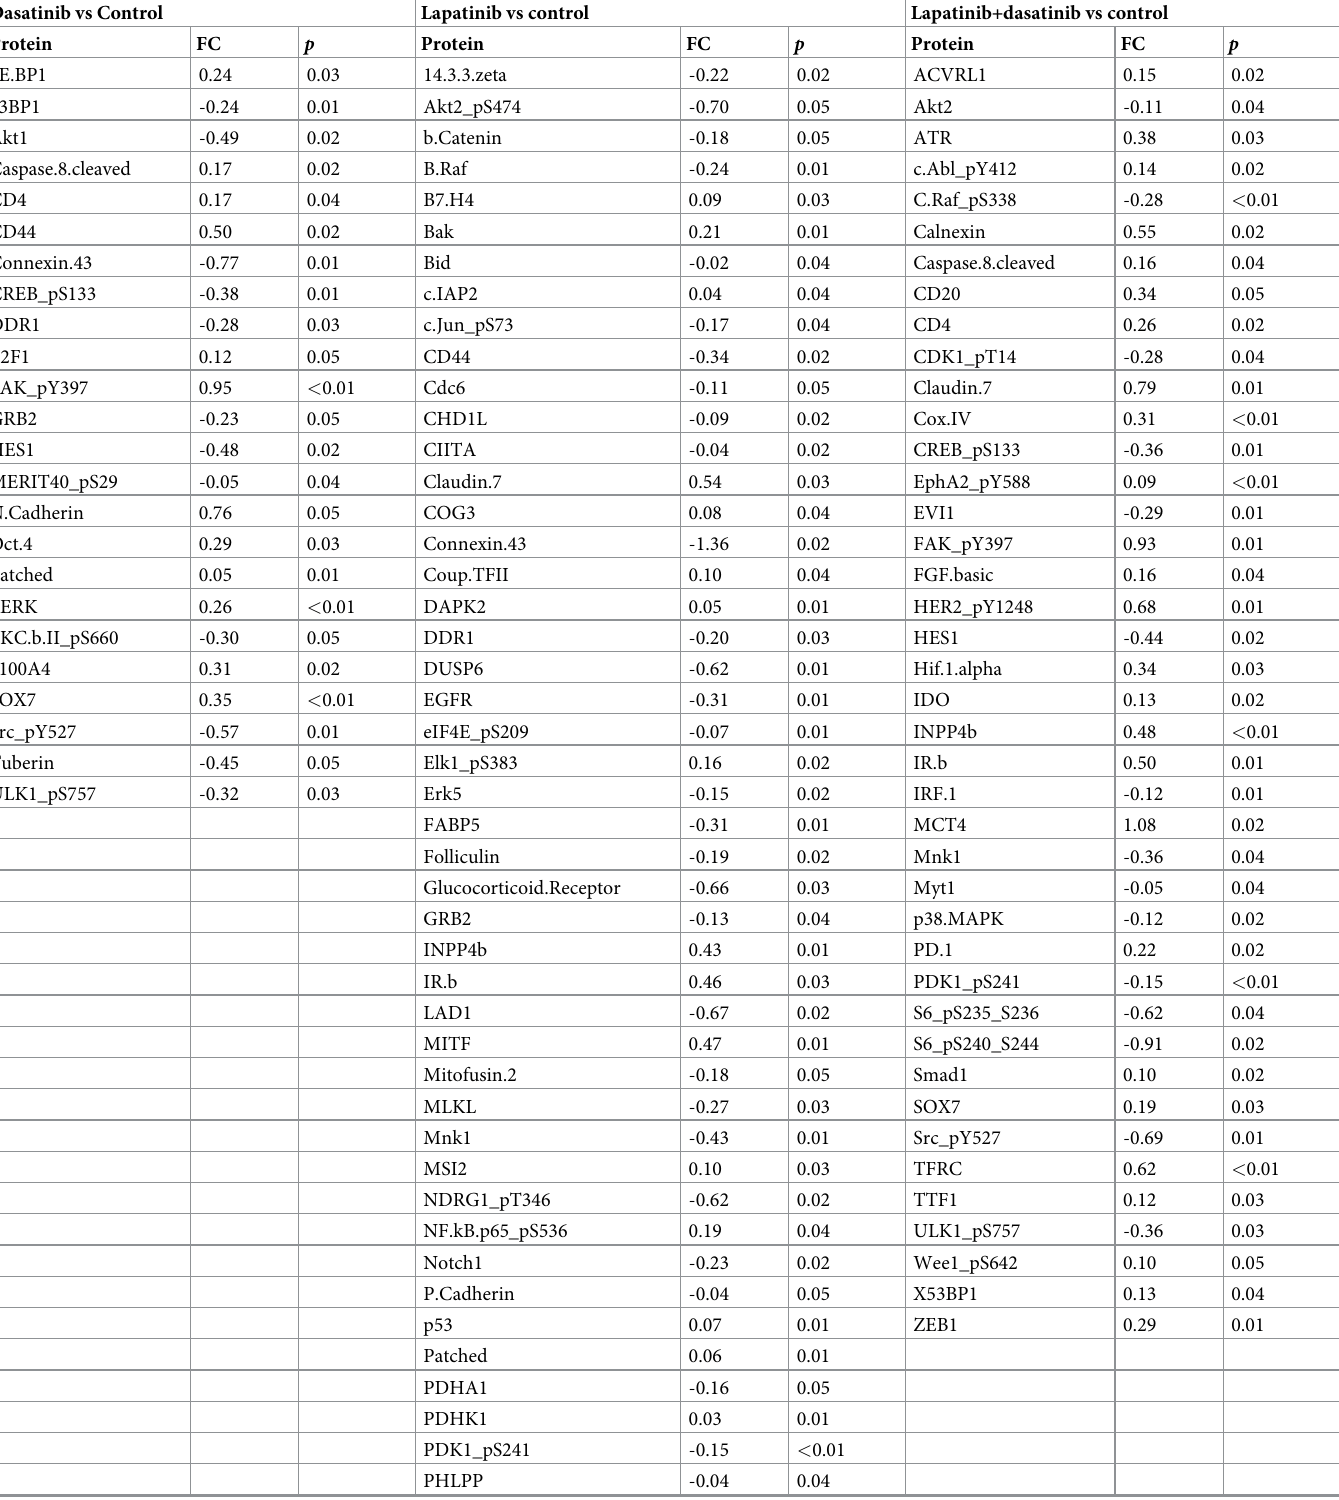
Table 1. Significantly affected proteins by TKIs alone or in